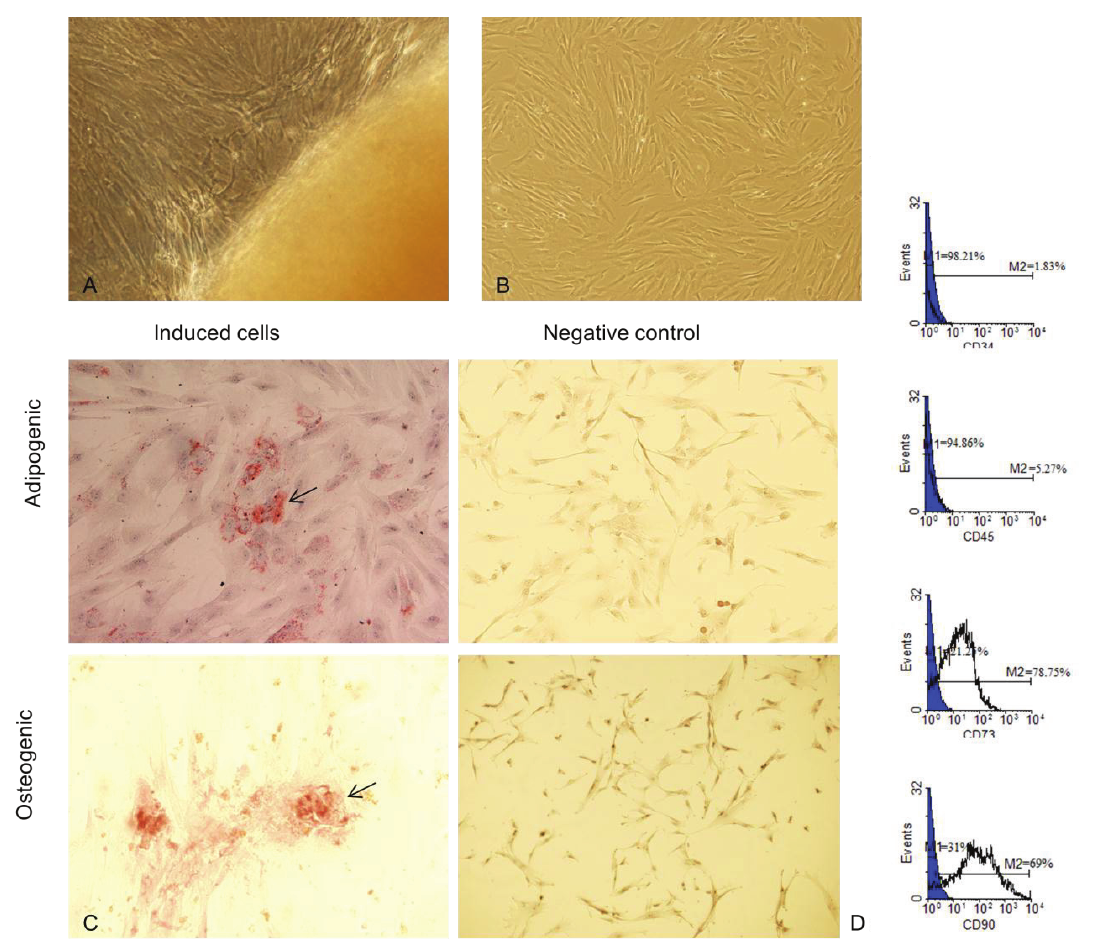
Figure 9: (A, B) hUCMs cells appeared with a fibroblast like morphology when in culture, showing short and long processes. (C) Osteogenic and adipogenic differentiation of hUCMs. Their adipocytic phenotypes were signaled by the appearance of tiny intracytoplasmic lipid droplets with Oil red. Calcium deposition and osteoid formation as shown by Alizarin red. Negative control showed no evidence of staining. (D) Flow cytometry results. The blue histograms are the isotype control-stained cells; the white histograms are the antibody-stained cells. hUCM cells were negative for hematopoietic markers; CD34 and CD45. These cells were positive for mesenchymal cell markers; CD73 and